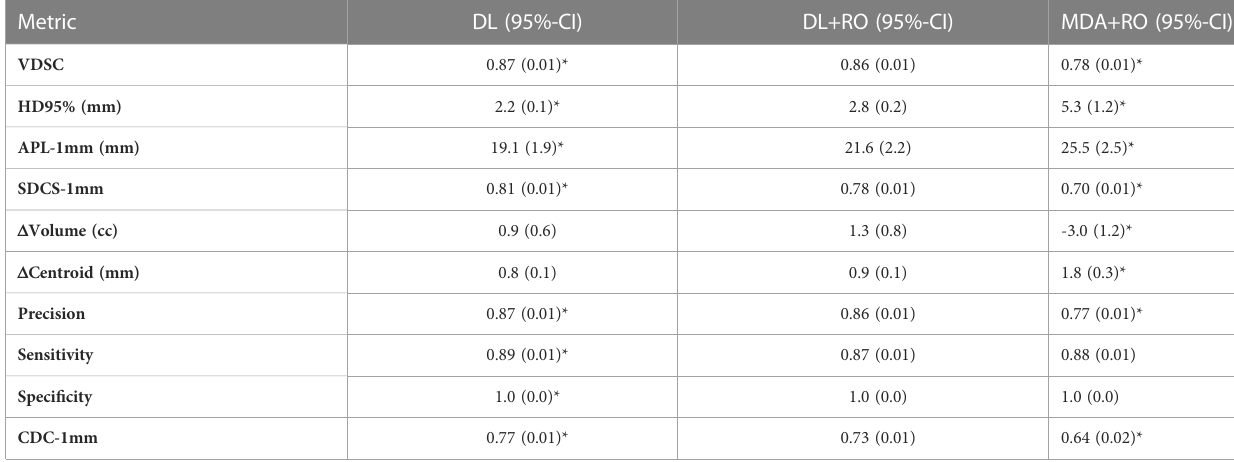
TABLE 2 Mean value (95%-CI) of select metrics of geometric agreement between each experimental arm and the GS for all contours for comparison (N=777).